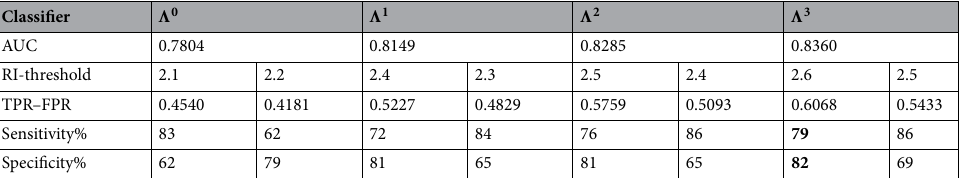
Table 1. Statistical measure of the performance of the classifiers and AUC. The sensitivity and specificity obtained for the best performing classifier-refractive index threshold association is given in